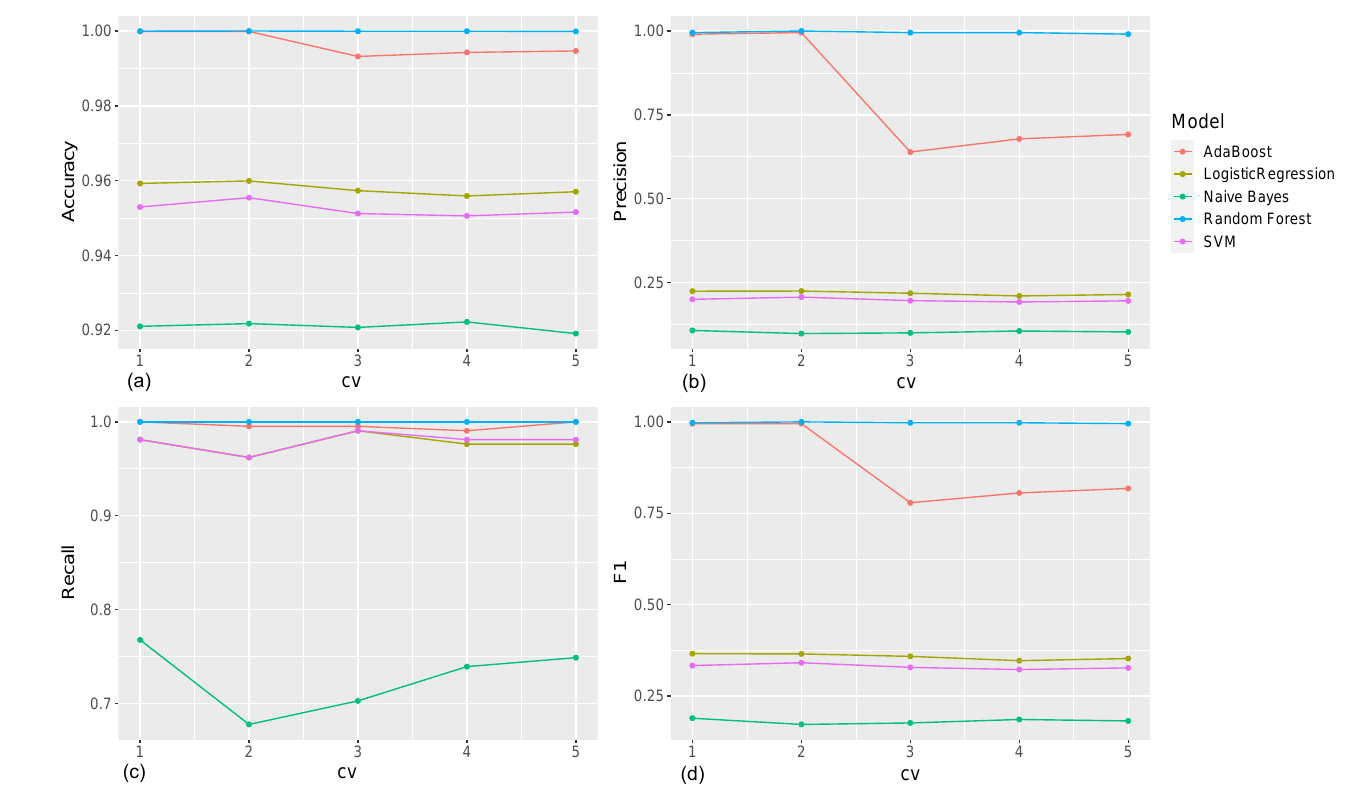
Figure 8. Metrics by iteration: ( a ) accuracy, ( b ) precision, ( c ) recall, and ( d ) F1.